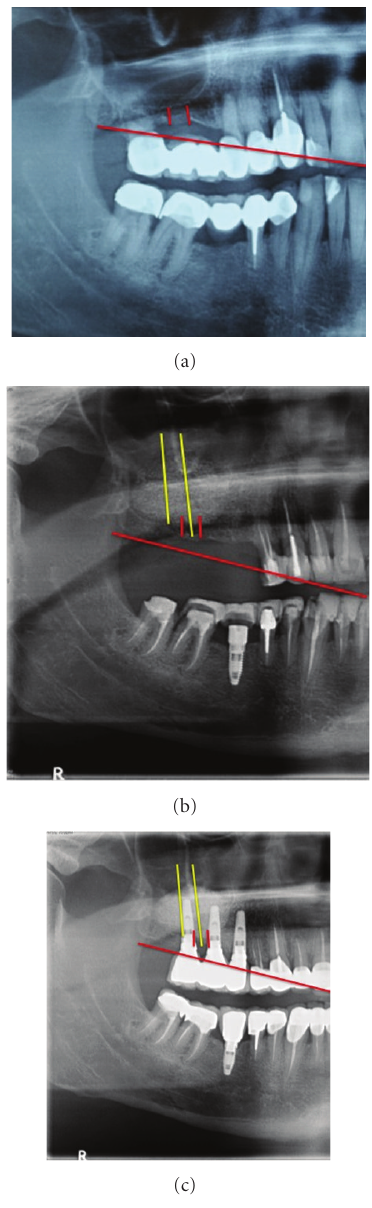
Figure 6: Panoramic X-ray with fixed measuring points at base line (a), after grafting procedure using Cerabone (b), and four years of implant placement